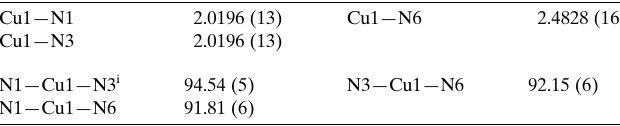
Table 1 Selected geometric parameters (A˚ , (cid:4)